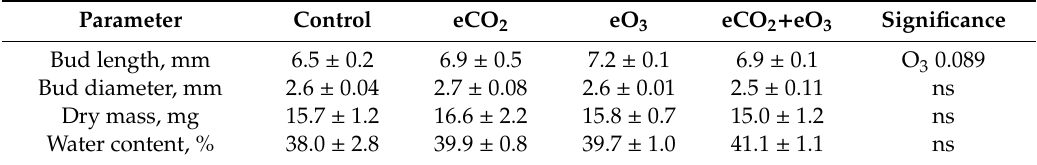
Table 4. Dry mass, water content and length of the buds of paper birch, sampled on April 4, 2009 (mean ± SE, n =